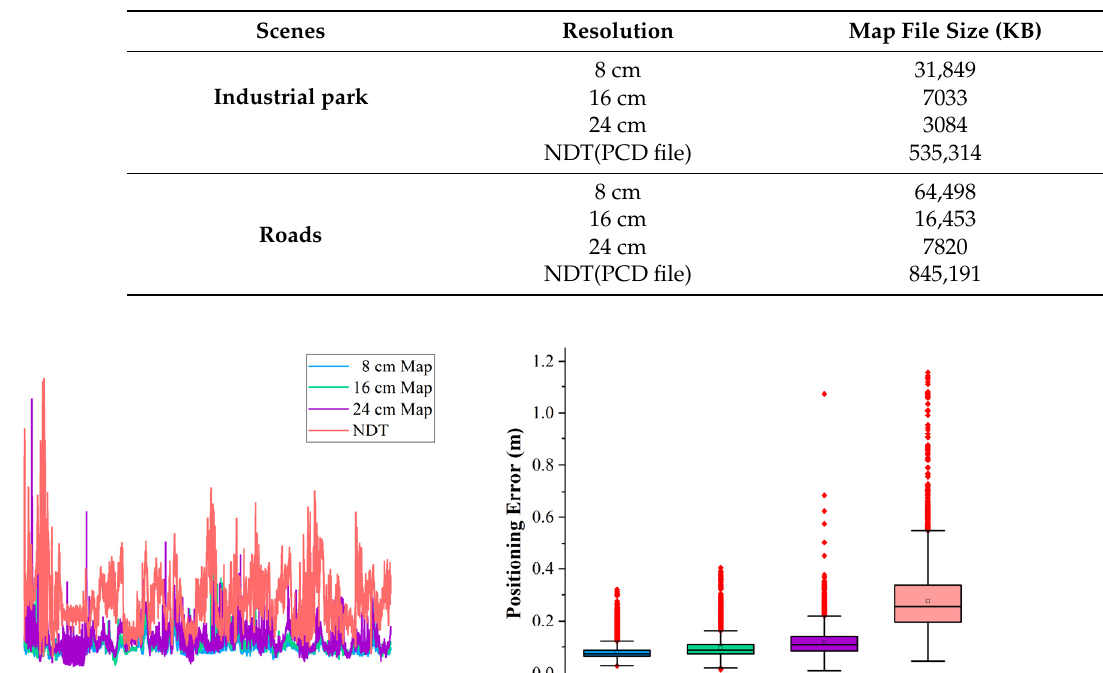
Table 2. File size of different resolution industrial parks and roads on the EQT map, PCD file size.